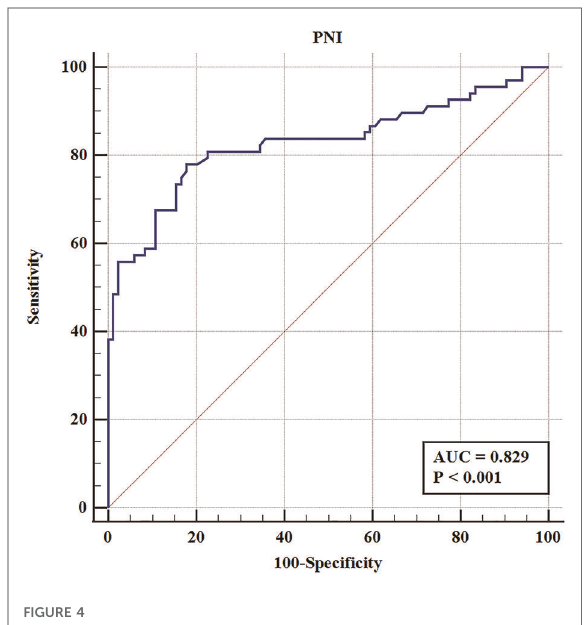
FIGURE 4 The ROC curve of PNI in overall RARC